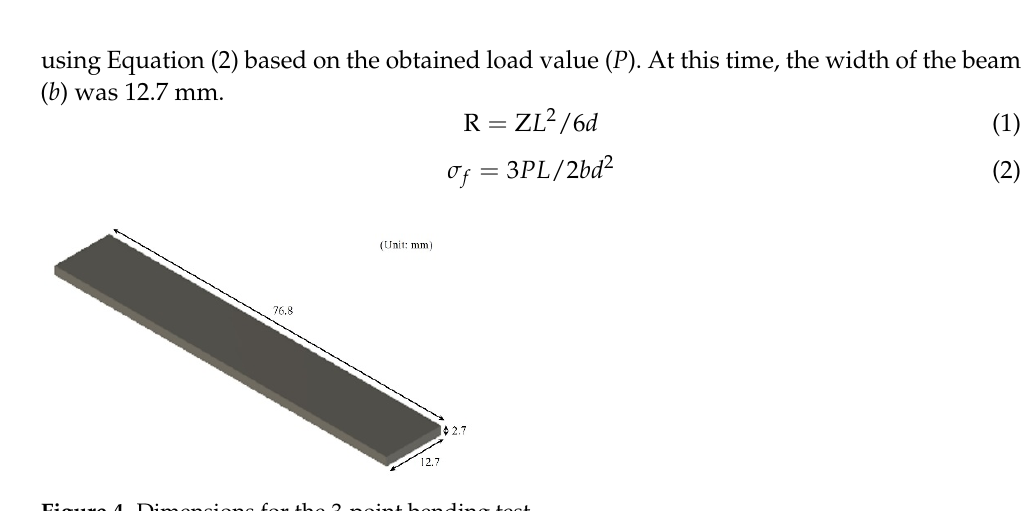
Figure 4. Dimensions for the 3-point bending test.